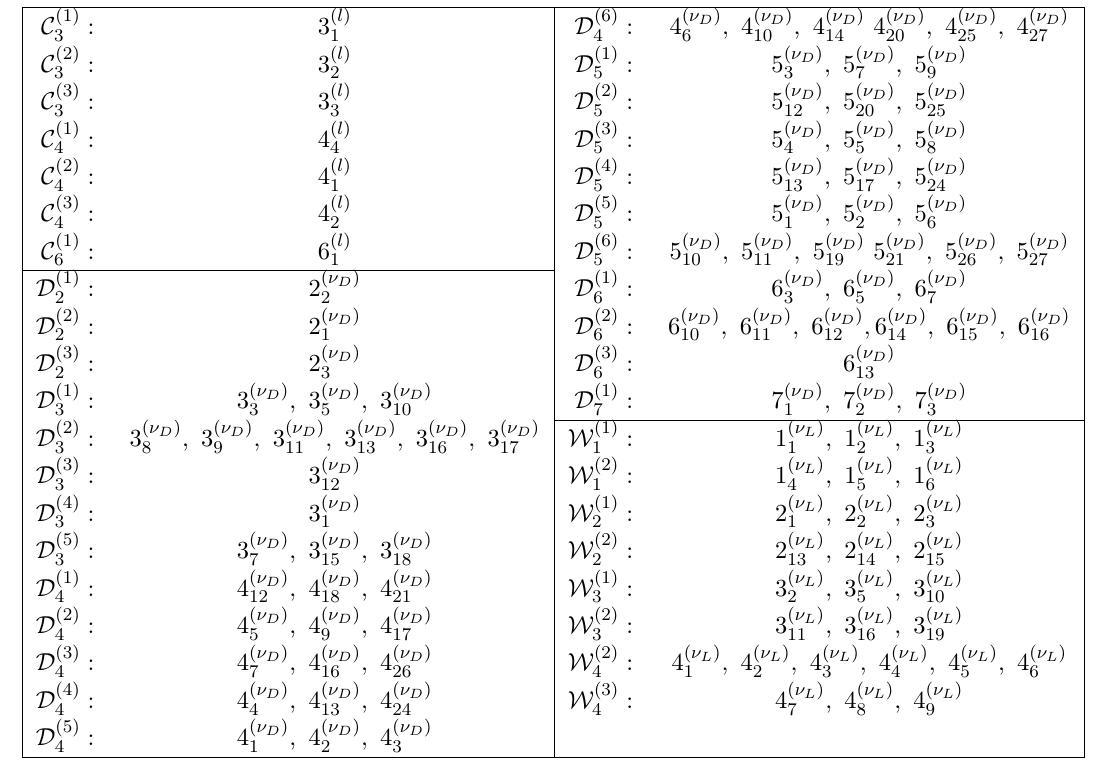
Table 6. Correspondence between our texture-zero patterns C , D and W and those of ref.